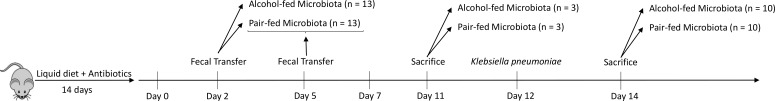
Schematic outline of the experimental protocol used in this study.C57BL/6 mice were administrered antibiotics daily for 14 days. Following antibiotic treatment mice were recolonized with cecal microbiota from alcohol-fed or pair-fed mice. Groups of mice were sacraficed 7 days following the final recolonization or infected intratracheally with K. pnuemoniae (~1x102 CFU in 100 μl of PBS) and sacrificed at 48 hours post infection.